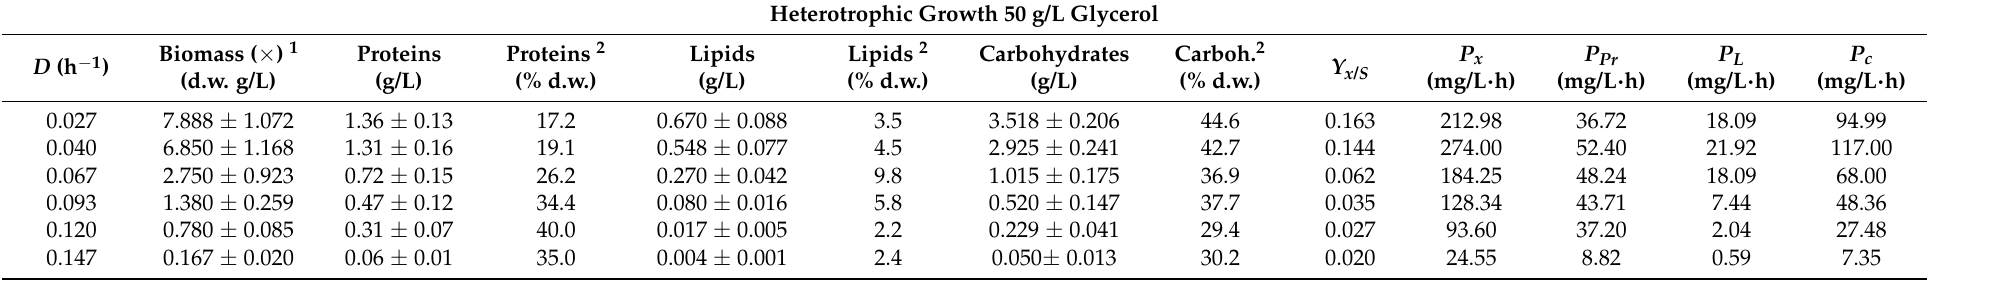
Table 2. Values of biomass, protein, lipids, and carbohydrates production (means ± SD) in a continuous flow culture of A. protothecoides with 50 g/L glycerol under heterotrophic conditions at steady state situations at various D . The productivities of biomass ( P x ) and metabolites ( P Pr for proteins, P L for lipids, and P c for carbohydrates) and Y x/S were calculated by the equations: P x = D · x , P m = D · m and Y x/S = x/S asimilated , respectively. Heterotrophic Growth 50 g/L